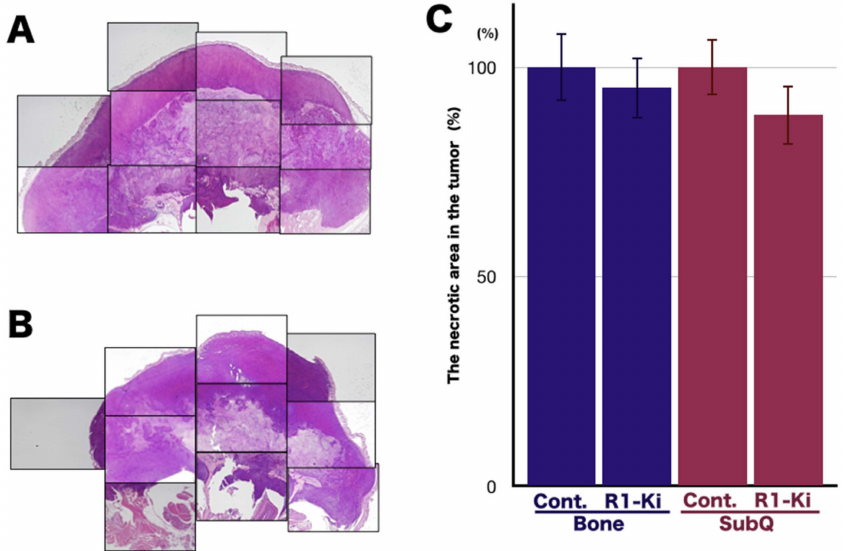
Figure 3. The e ff ect of TGF- β signaling on the induction of necrotic area. ( A , B ): Evaluation of the necrotic area in the tumors by microscopic analysis and image analyzer in the control group ( A ) and R1-Ki treatment group ( B ). Magnification: 2 × . C : Quantitative analysis of the necrotic area: R1-Ki had no e ff ect on the necrotic area in either the bone or subQ micro-E.